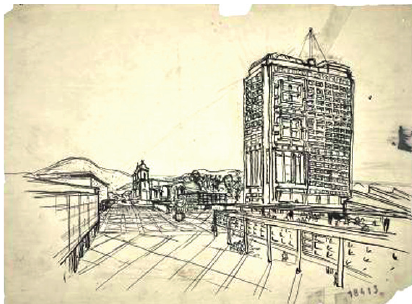
fig. 4. View through the main axis, old main rue Thiers, with the cathedral, the admistrative skyscraper and the mountains on the background. le Corbusier, Scketch august 1945.